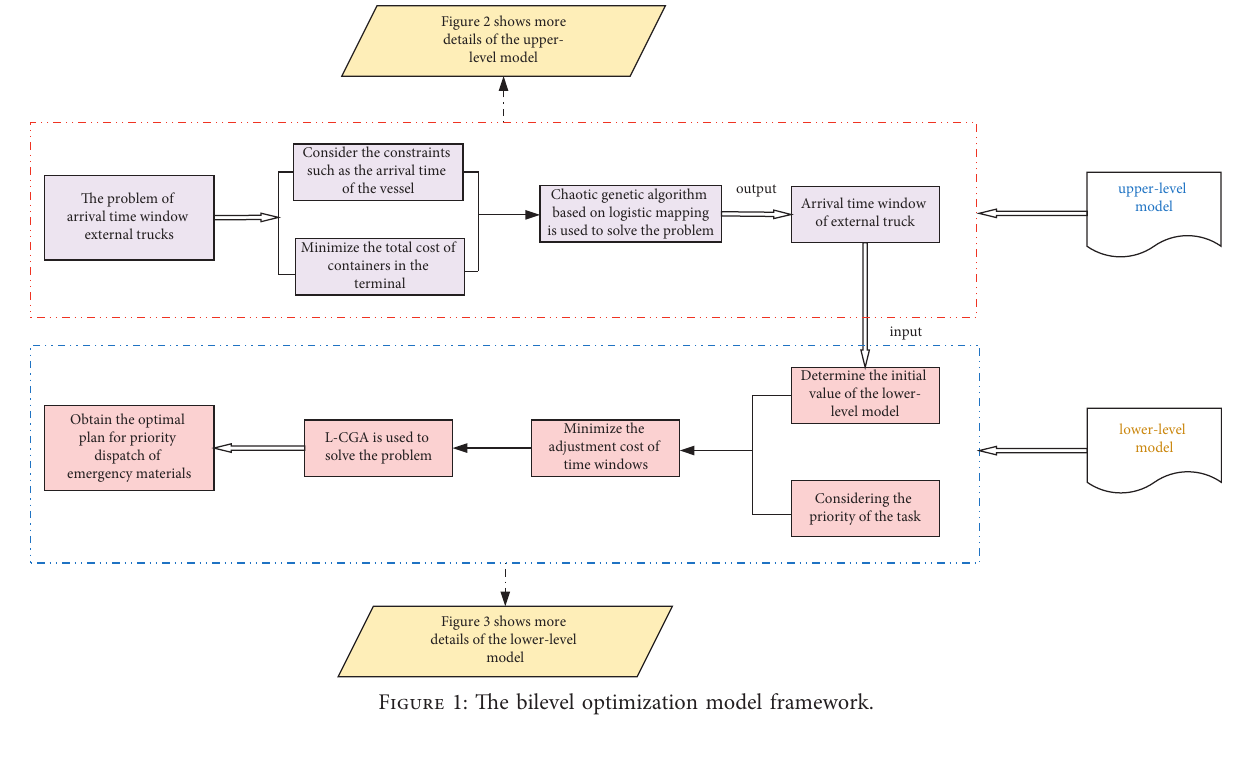
Figure 1: The bilevel optimization model framework.